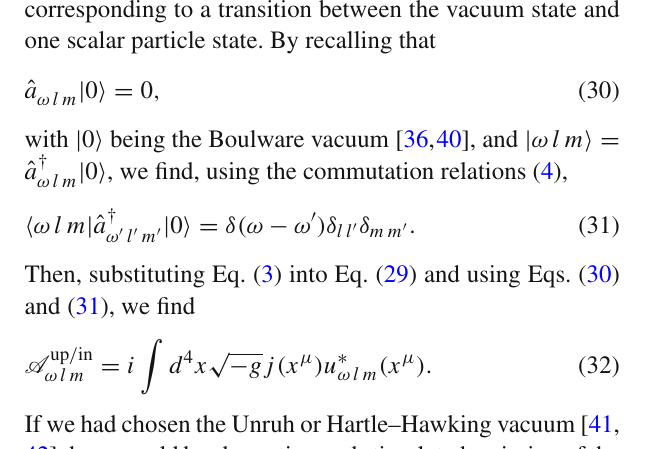
( r 0 → ∞ ) with initial velocity v 0 = 0 . 5, v 0 = 0 . 75 and v 0 = 0 . 95 (plots on the left) and for a source infalling from rest ( v 0 = 0) released at positions r 0 = 5 r h , r 0 = 2 . 5 r h and r 0 = 1 . 1 r h (plots on the right)